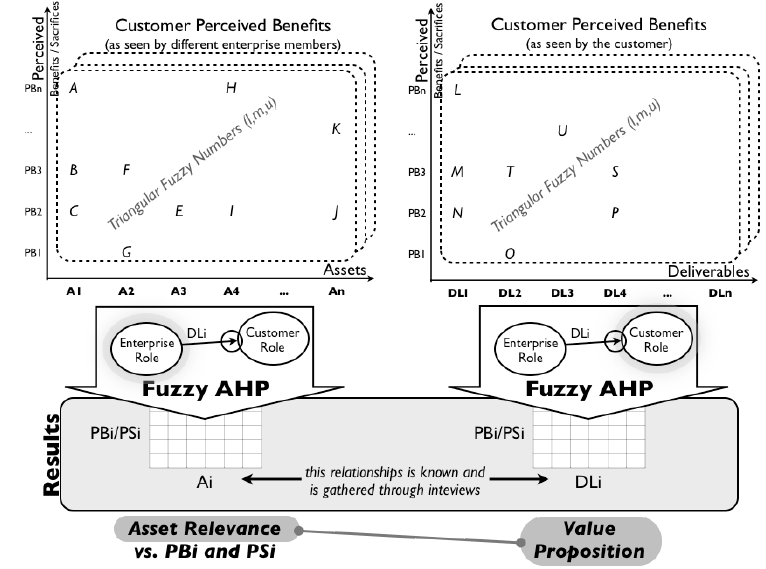
Fig. 4. Wrap-up and assessment of